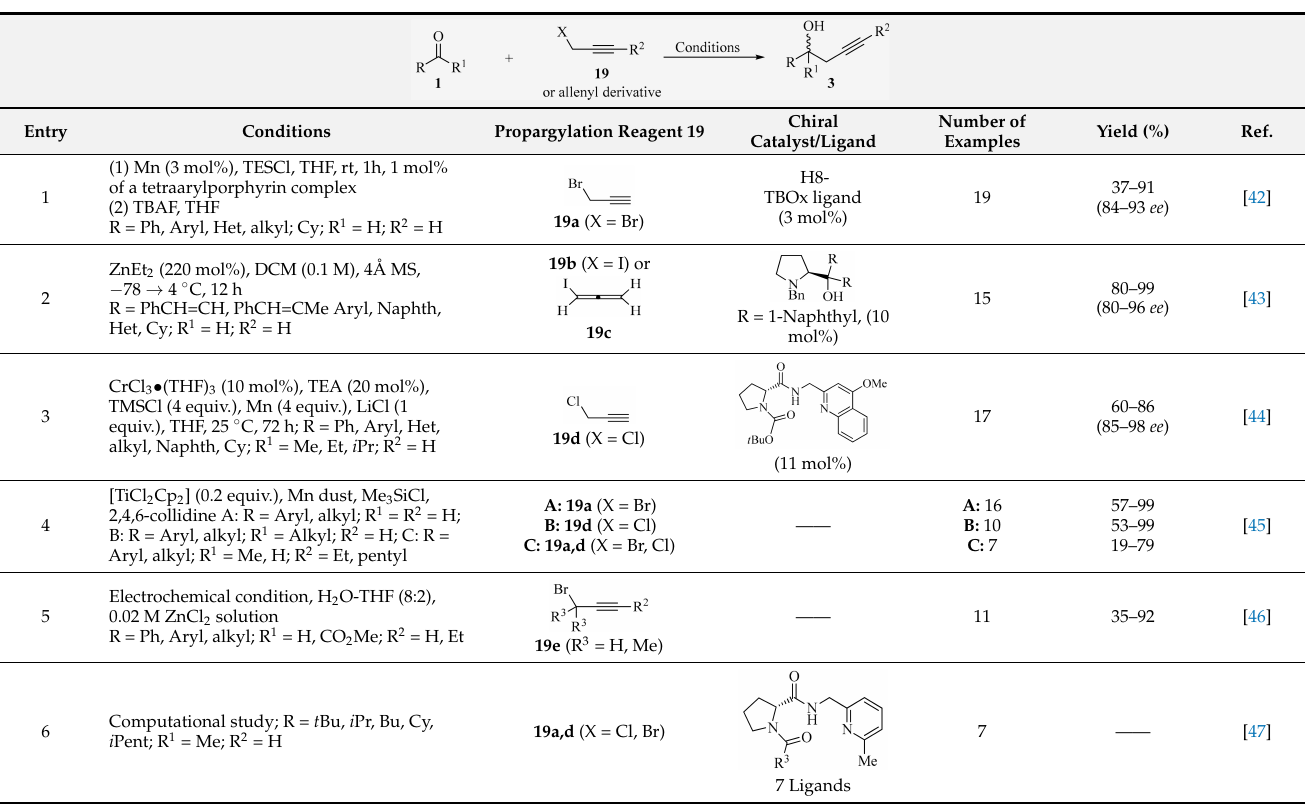
Table 3. Propargylation of diversely substituted aldehydes/ketones 1 with propargyl-/allenyl halides 19